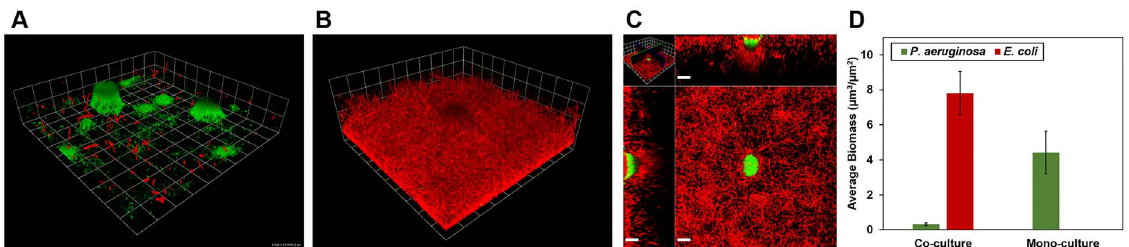
Figure 1. Colonization of P.aeruginosa biofilms by E.coli in R2A medium in a microfluidic flow cell. E. coli appears red and P. aeruginosa appears green or yellow. A) E. coli deposited on 3-day old P. aeruginosa biofilm (grid unit is 23.8 m m). B) Resulting mixed E. coli – P. aeruginosa biofilm on day 6 (grid unit is 23.8 m m). C) Horizontal section near the base of the biofilm and vertical sections of the biofilm shown in panel B (scale bar=20 m M). D) P. aeruginosa and E. coli biomass in mixed biofilms on day 6 compared with biomass of 6-day old mono-cultured P. aeruginosa